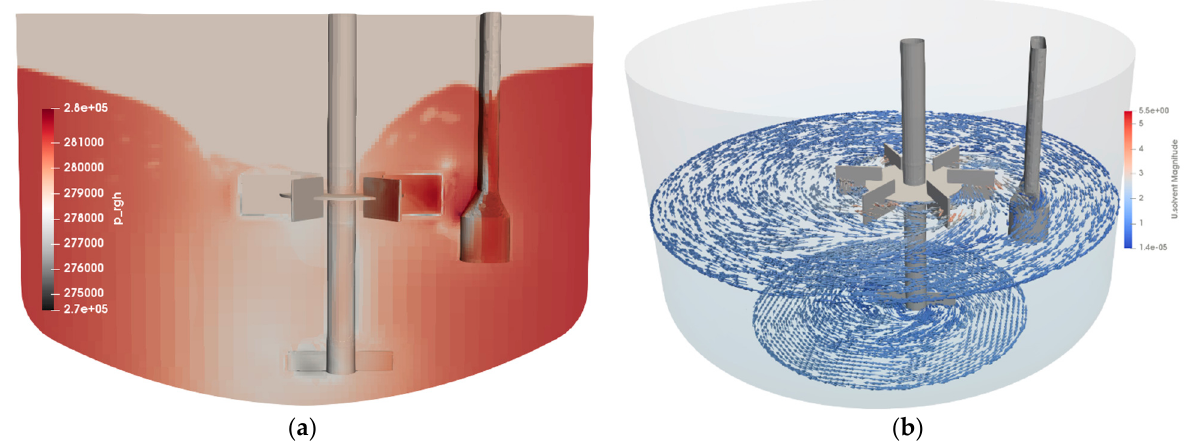
Figure 9. Visualisation of dynamic pressure levels ( a ) in a cross-section of the tank at Y = 0, and solvent velocity vectors ( b ) at horizontal cross-sections at Z = − 0.5 m and Z = 0 m at t = 90 s.